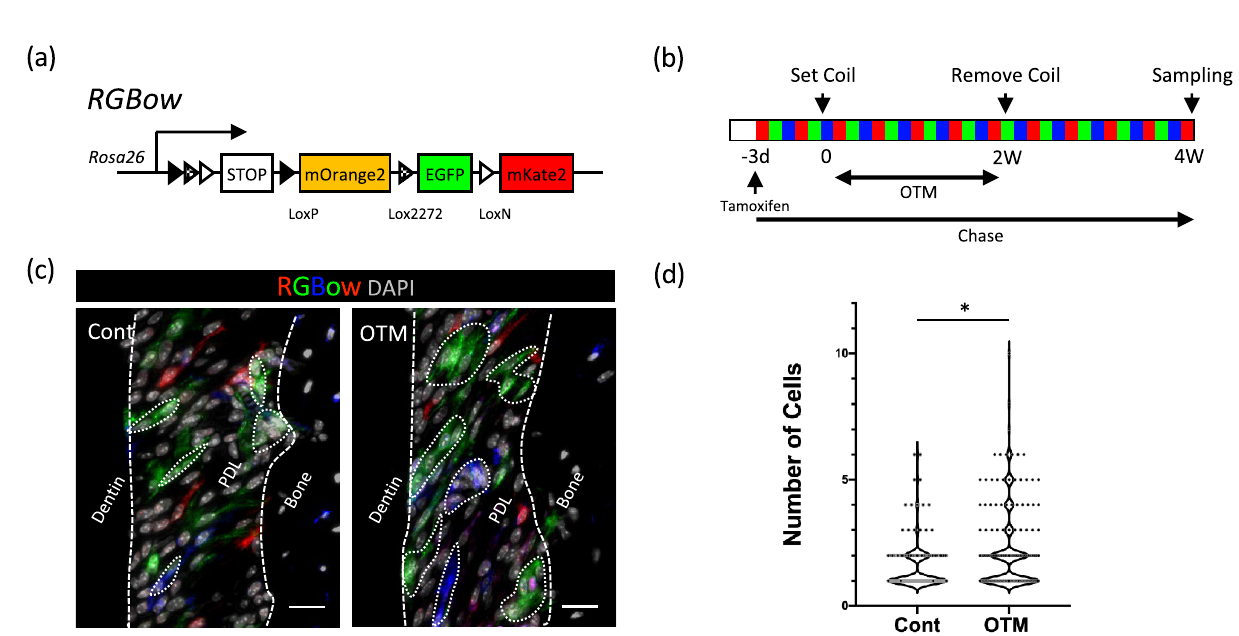
Figure 5. In vivo cell clonal analysis. ( a ) Schematic of the RGBow reporter construct. Tamoxifen-dependent Cre-recombinase generates three fluorescence proteins at random. ( b ) Schematic experimental schedule of in vivo cell clonal analysis. ( c ) Representative images of the analysis using RGBow: UBC-CreER T2 mice. Single-cell-derived cell clones were visualized with three pseudo colors (red, green, or blue). The cell clusters are marked with a dotted line. Bar: 50 μm. ( d ) The number of cells in each cluster increased significantly from 1.5 ± 0.9 to 2.2 ± 1.6 by OTM. *p <